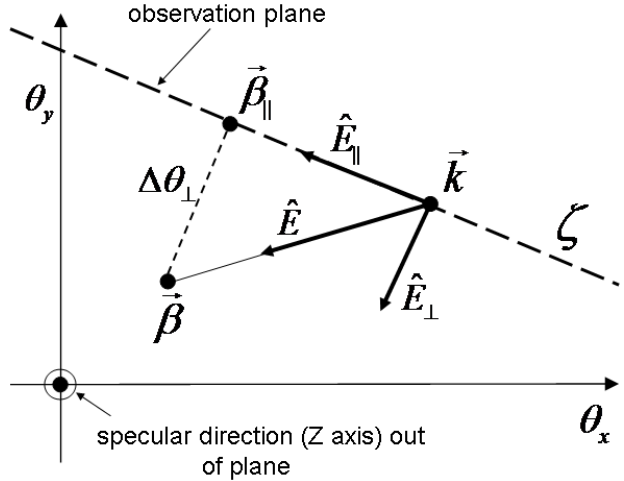
FIG. 2. Schematic of the detection